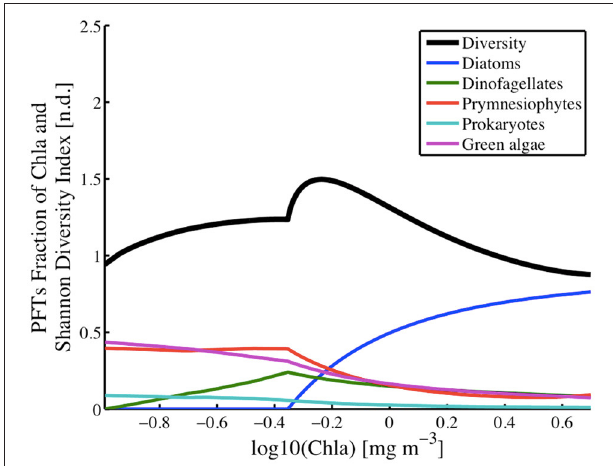
FIGURE 11 | Phytoplankton functional types (fraction of chlorophyll a) for Diatoms, Dinoflagellates, Prymnesiophytes, Prokaryotes, and Green Algae, and Shannon Diversity Index (H; n.d.) plotted against the log of Chl SAT over the whole study